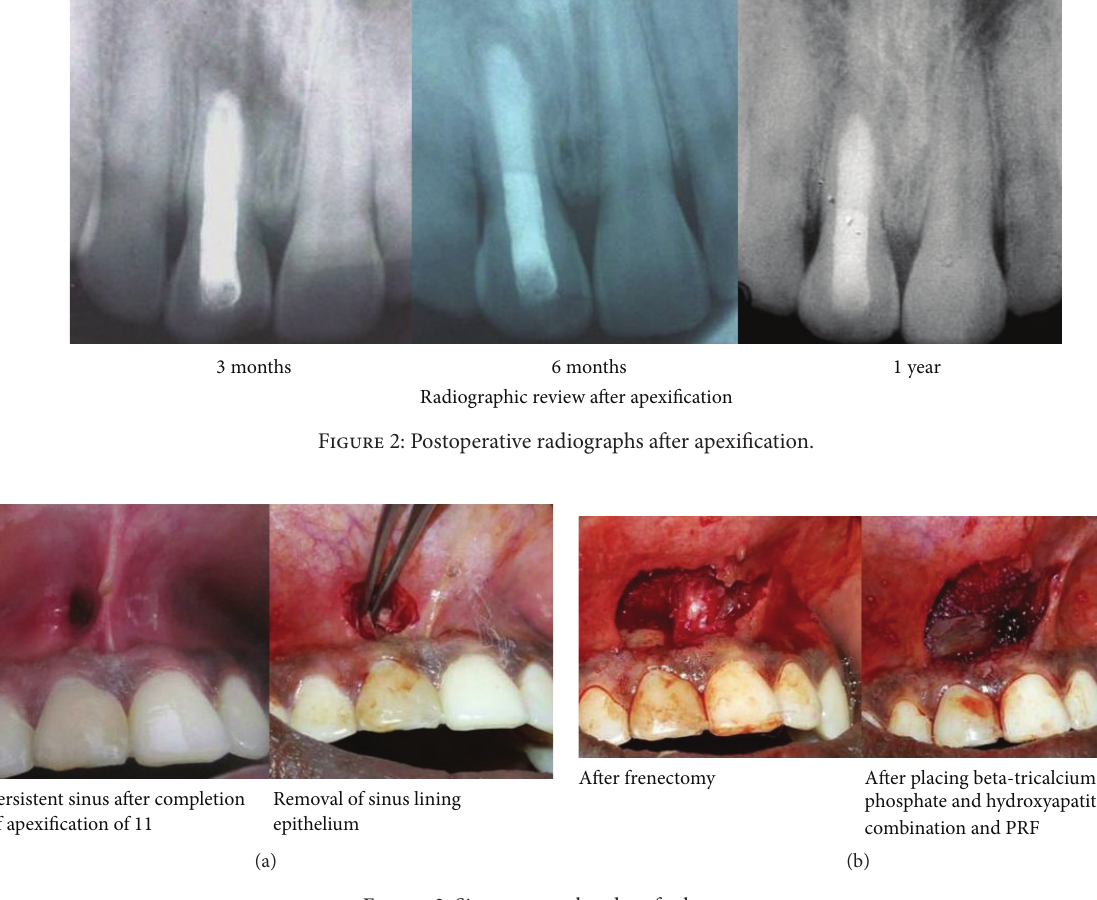
Figure 3: Sinus removal and graft placement.